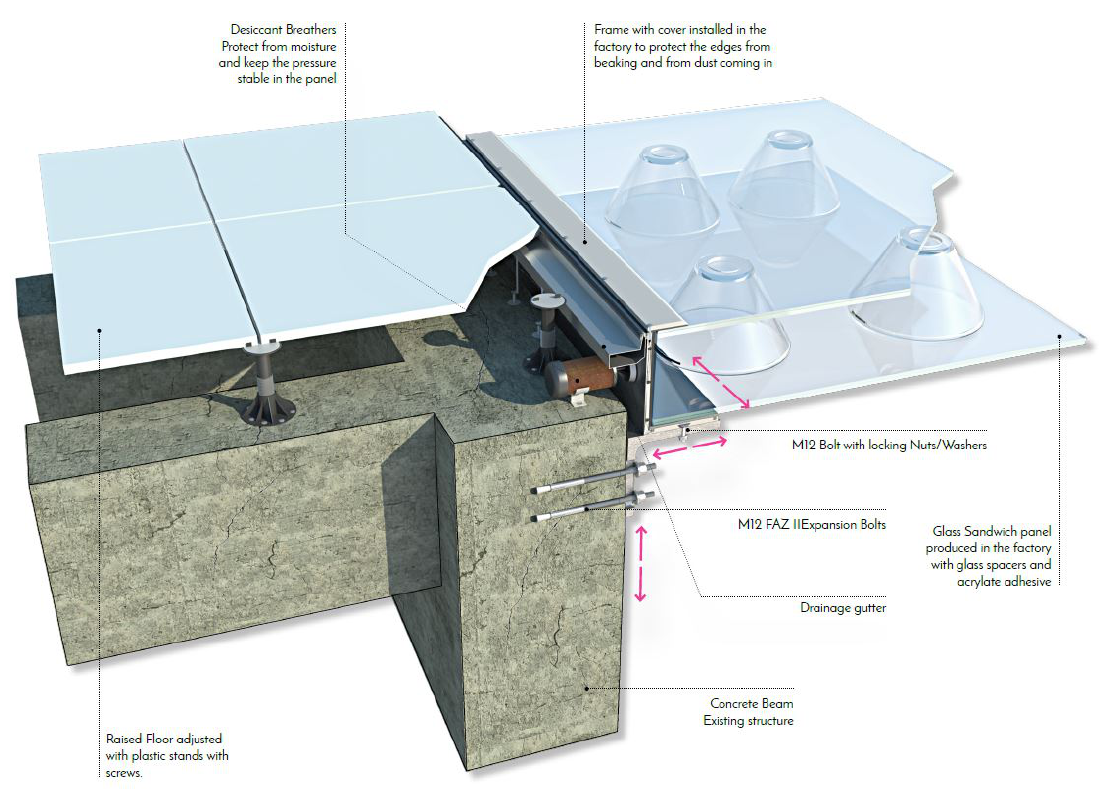
Fig. 18: schematic detail showing the installation of the